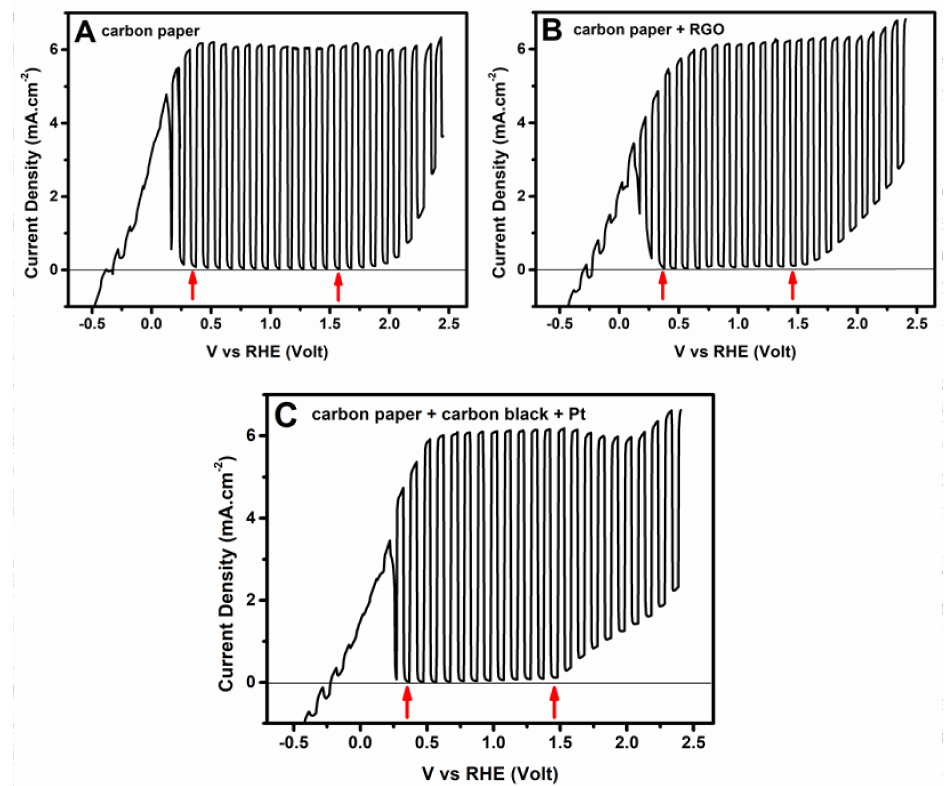
Figure 4. Current density–voltage curves recorded by a light chopping mode with the same CdS/TiO 2 /FTO photoanode, but with different counter electrodes: ( A ) carbon paper; ( B ) carbon paper + RGO; and ( C ) carbon paper + carbon black + Pt. The electrolyte was 0.5 M NaOH. 10% v / v ethanol was added in the anode compartment. The scan rate was 5 mV/s. In each plot, there are two arrows. The arrow on the left indicates the voltage where the capacitance current becomes zero. The arrow on the right shows the voltage where water electrolysis